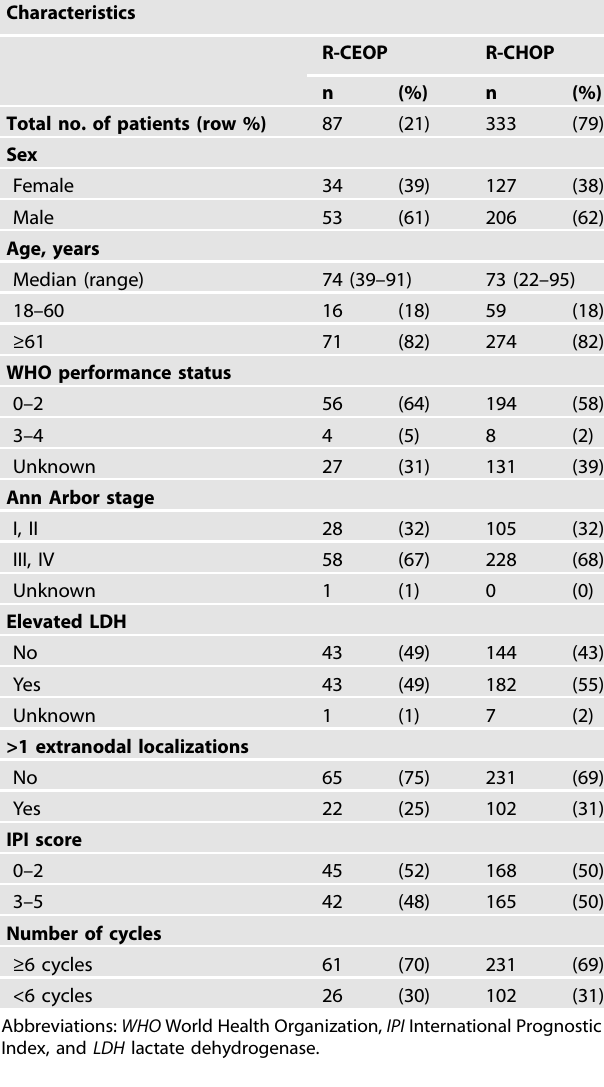
Table 1. Characteristics of patients with a diffuse large B-cell lymphoma receiving R-CEOP or R-CHOP.